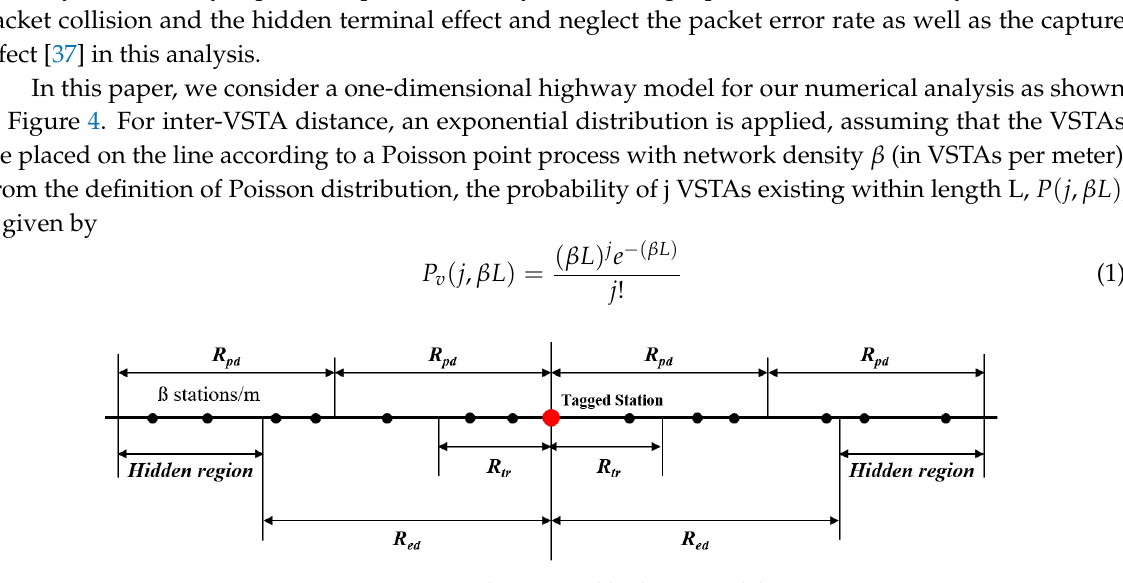
Figure 4. One-dimensional highway